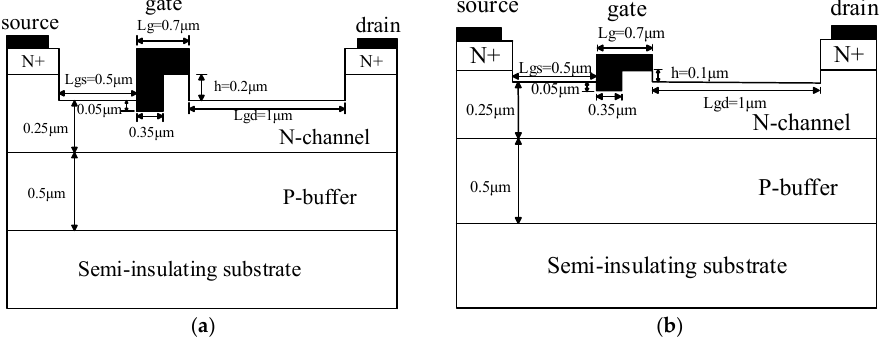
Figure 1. ( a ) Structural cross sections of ultrahigh upper gate 4H-SiC metal semiconductor field effect transistor (UU-MESFET); ( b ) Structural cross sections of improved ultrahigh upper gate 4H-SiC metal semiconductor field effect transistor